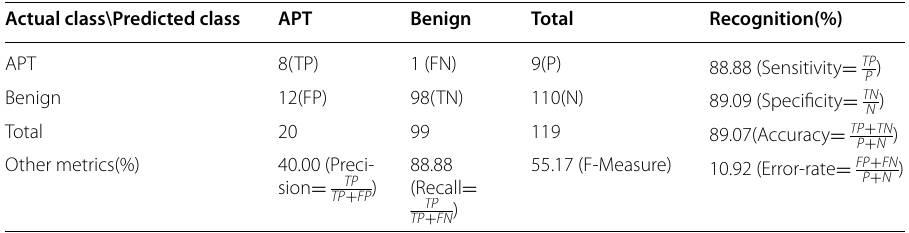
Table 12 Results of